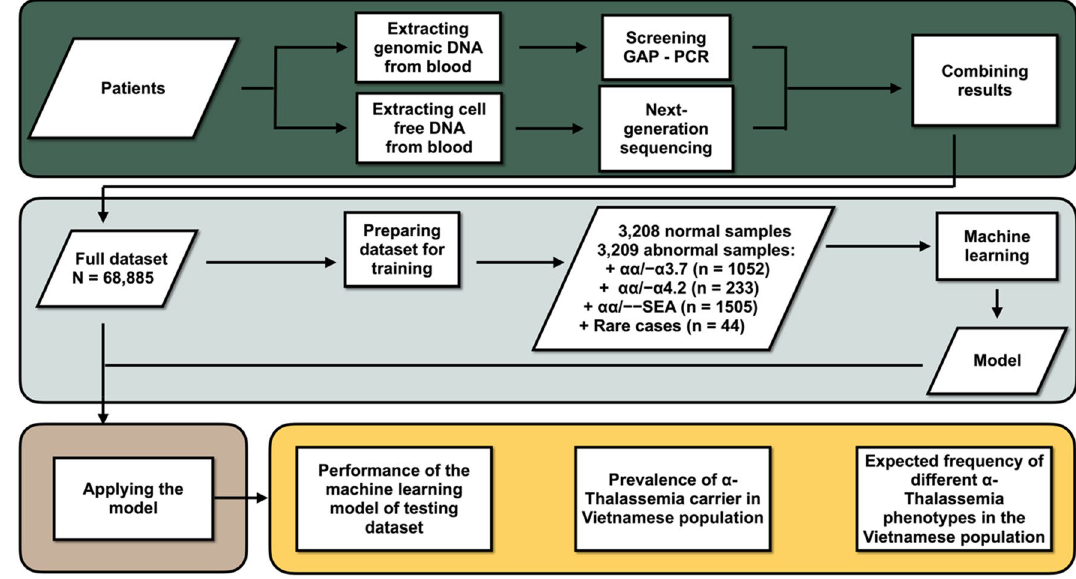
Figure 1. Flow chart of the framework and